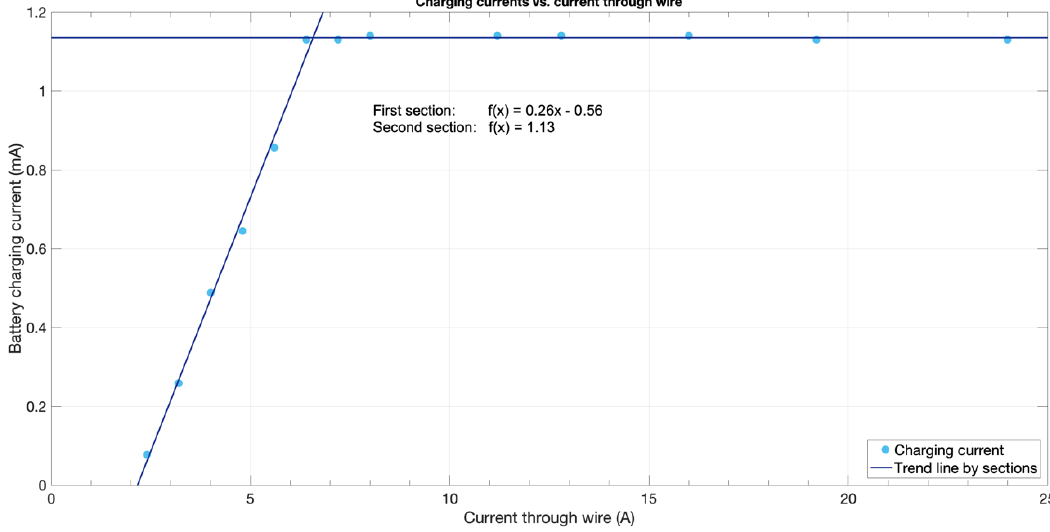
Figure 14. Charging currents for different currents in the mains wire.